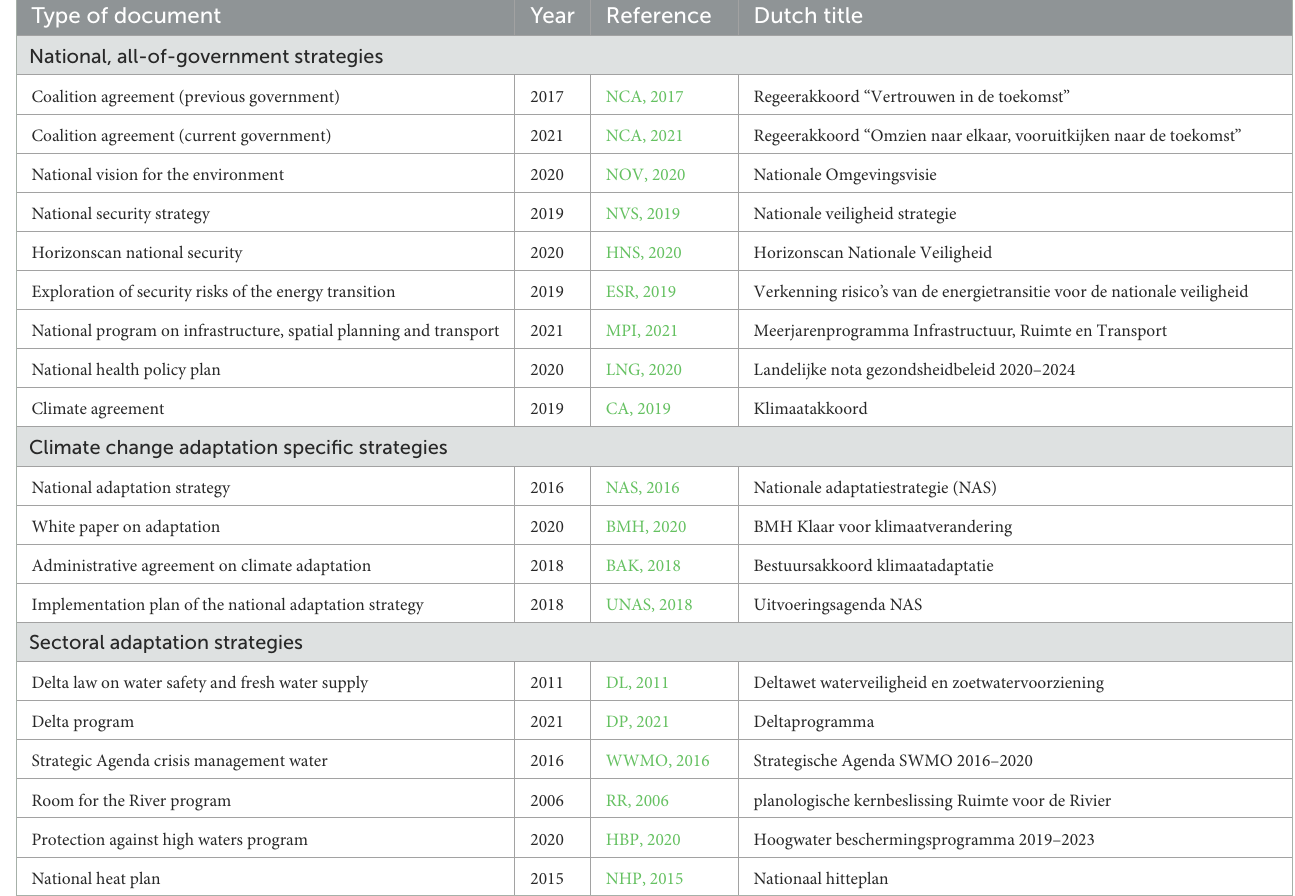
TABLE 2 Selected national policy documents (19).